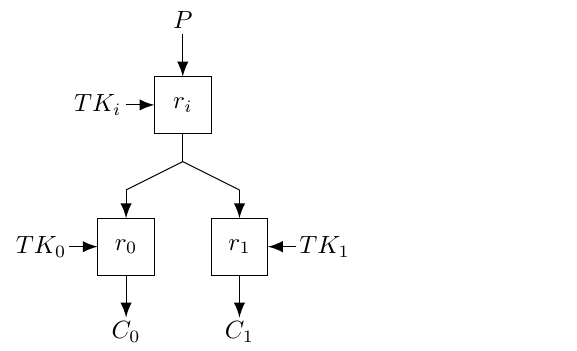
Figure 1: Illustration of an encryption by a forkcipher. Each box corresponds to several rounds of a block cipher round